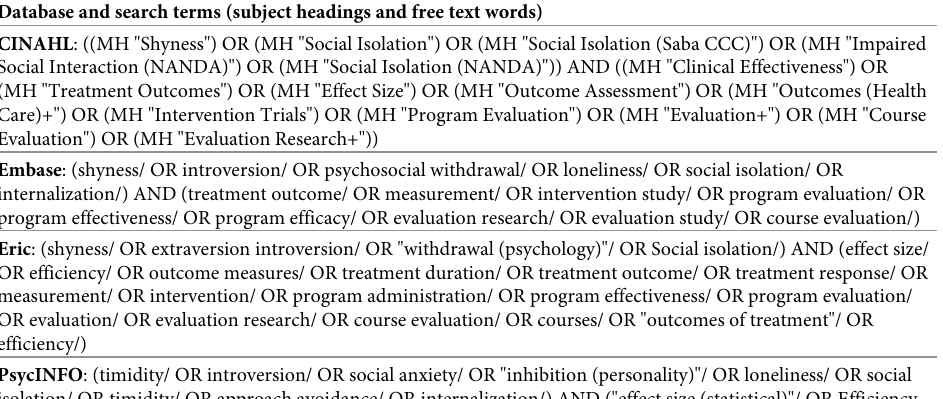
Table 1. Search strategies per literature database. Database and search terms (subject headings and free text